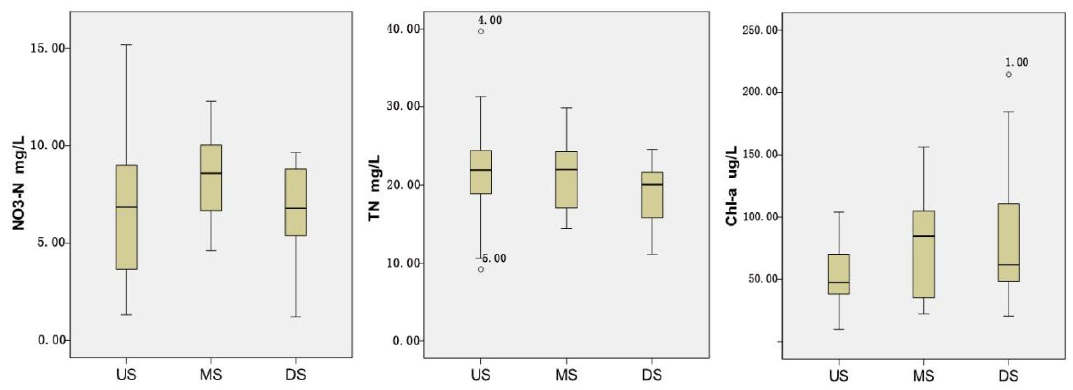
Figure 4. The trend of spatial variations of significant water quality parameters in TSBR.